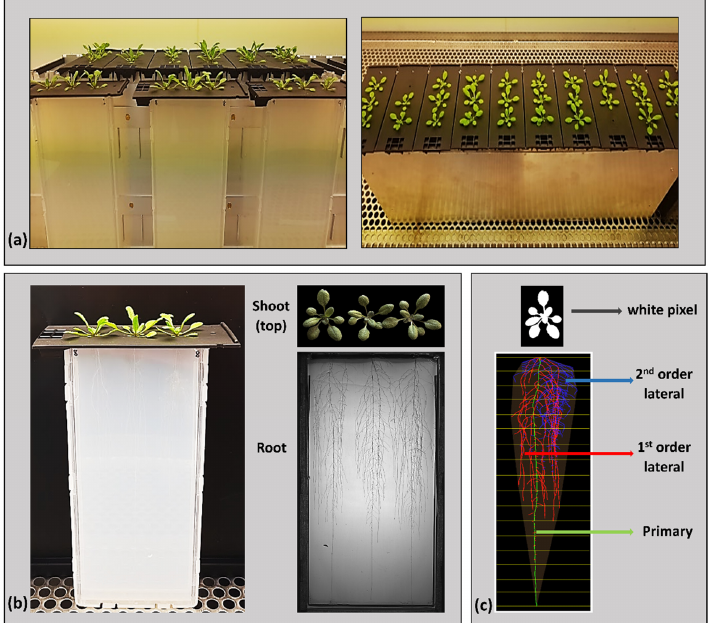
Figure 1. GrowScreen-Agar II: Plant cultivation setup and root/shoot image acquisition and anal- ysis. ( a ) Arabidopsis plants growing in customized plates and magazine (product specification on Figures S1 and S2, respectively). Black plate collars provide the background for the growing shoots outside of the plates, while at the same time they exclude light entering the top of the metal magazine ( bottom panel) to provide dark environment for the roots. ( b ) Overview of a single plate that is manually transferred to an imaging system (Figure S3) equipped with cameras for imaging the shoots and the roots, generating two images: top view of the shoot(s) and the whole root system. ( c ) ( Top ) Analysed image of a rosette using the Colour segmentation tool that computes the sum of white pixels as a proxy to compute the projected leaf area [59]. ( Bottom ) Analysed image of a root system using the GrowScreen-Root software [52]. Different root types are distinguished by color: green for primary roots, red for 1st-order lateral roots, and blue for 2nd-order lateral roots. The whole image area can also be divided horizontally into several sections to extract root length density per